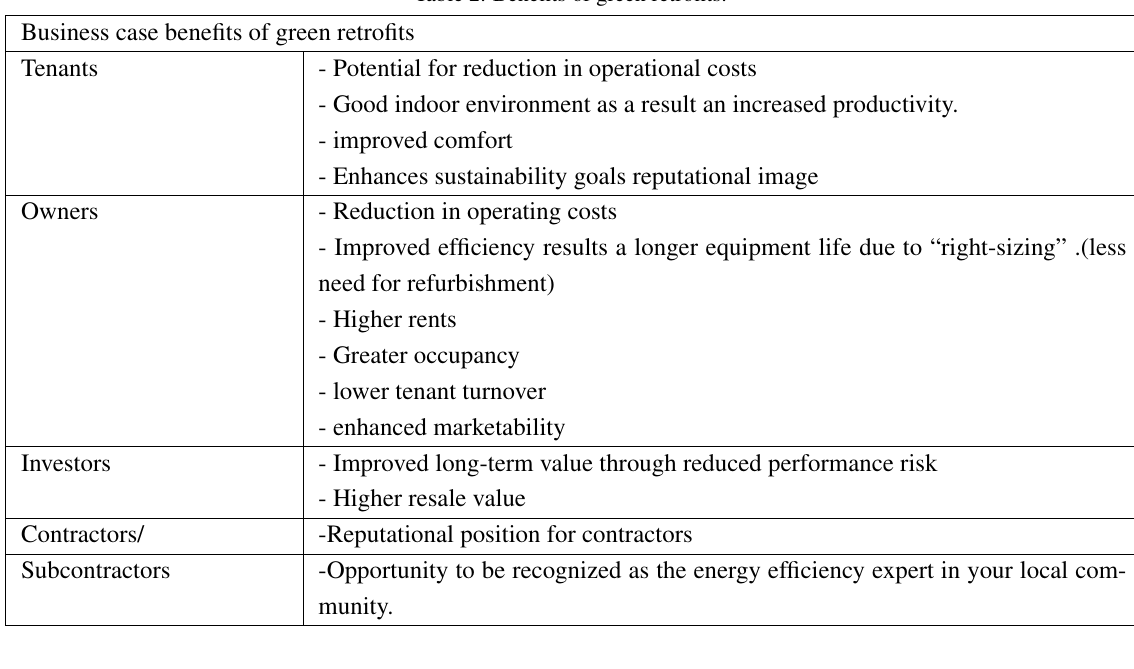
Table 2. Benefits of green